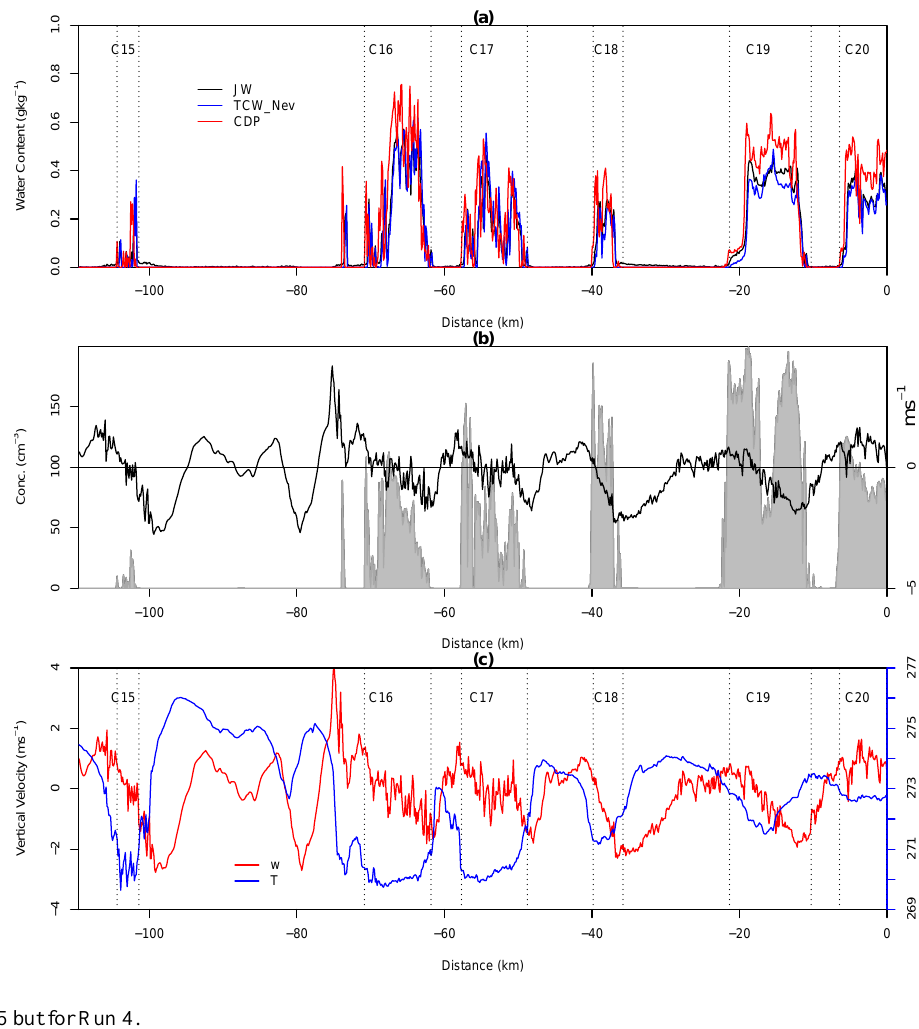
Fig. 9. As in Fig. 5 but for Run 4.